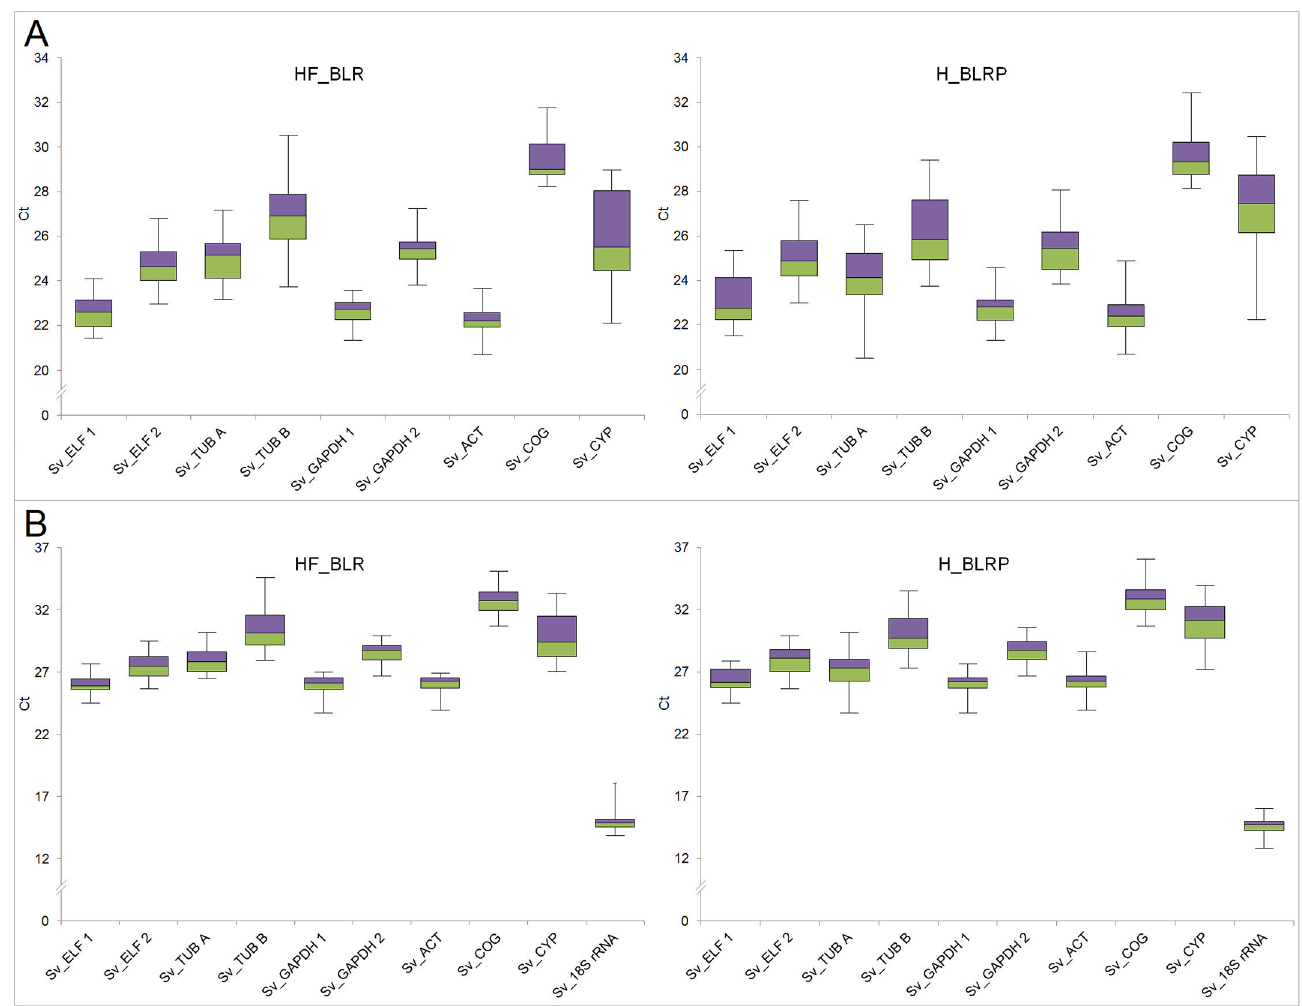
Fig 2. Box-plot of threshold cycle (C t ) values of the candidate referencegenes. Flower buds, leaves, roots and pollen(BLRP) or in flower buds, leaves, roots (BLR) were analyzed. A : Oligo dT primedcDNAs. B : Randomhexamer-primed cDNAs. Graph shows the median values as line across the box. Lower and upper box boundaries indicate the 25 th percentileand the 75 th percentile,respectively. Whiskers represent the maximum and minumum